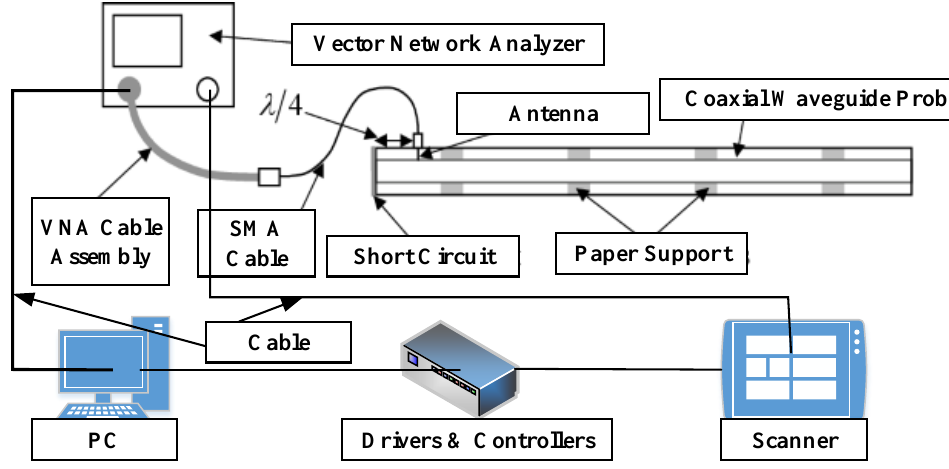
Figure 9. Microwave framework for corrosion detection and monitoring under coating